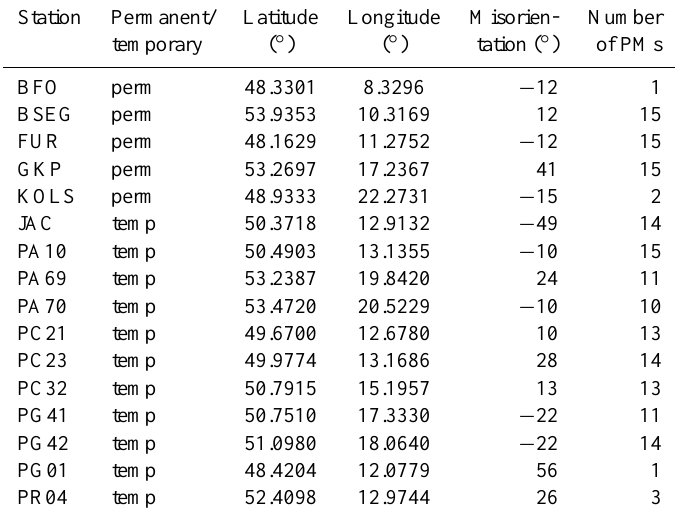
Table 1. Estimated deviations of misaligned seismometers.